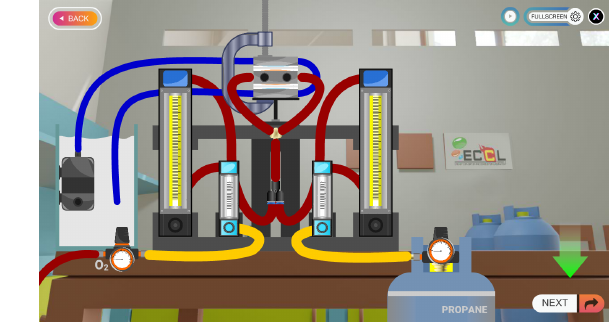
Figure 7: Assembling the micro power generation